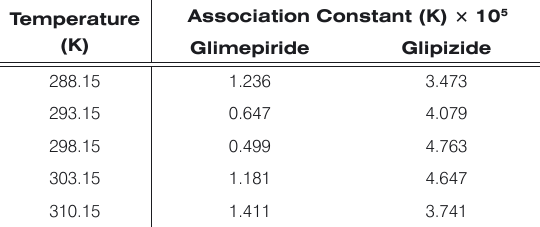
Table 2. Association constants for the binding of glimepiride and glipizide to human serum